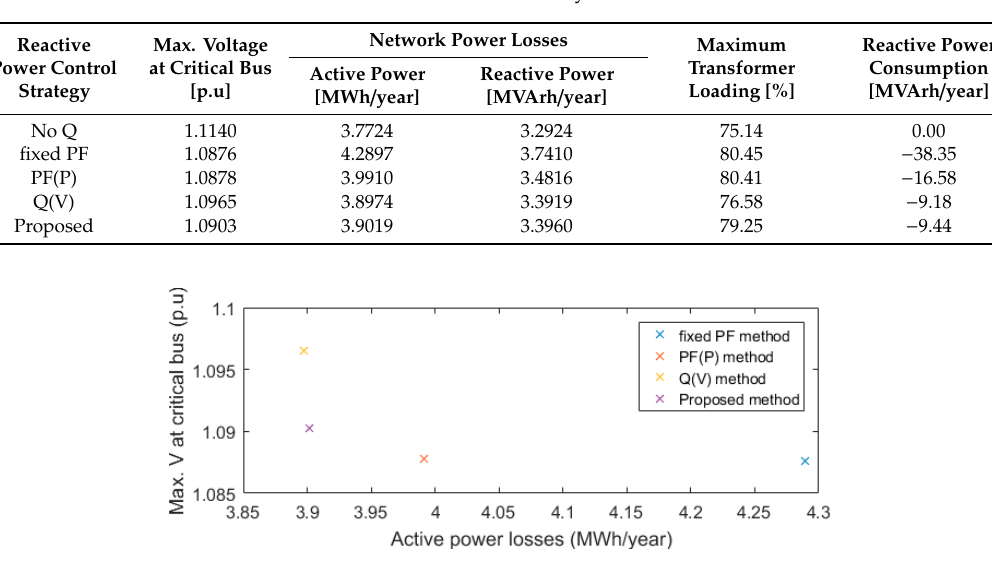
Figure 15. Comparison of max voltage at critical bus and grid losses according to reactive power control